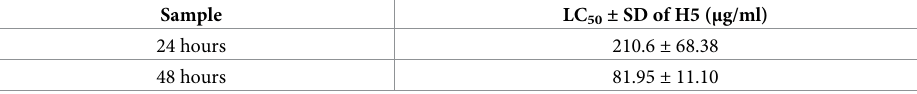
Table 2. Artemia salina toxicity test of hydrazone H5.